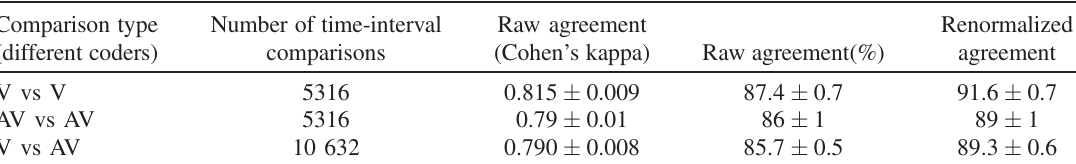
III. Top two rows: Using three different metrics, interrater reliability is high for both V (video only) and AV (audiovisual) modes of coding. Bottom row: Intermode reliability (V vs AV) is high. Bottom two rows: Two coders using different modes (V vs AV) have equivalent interrater reliability as two coders both using AV (same mode). Then, coders ’ results for both videos are compared two at a time and averaged over coder combinations. Error is the standard error of the